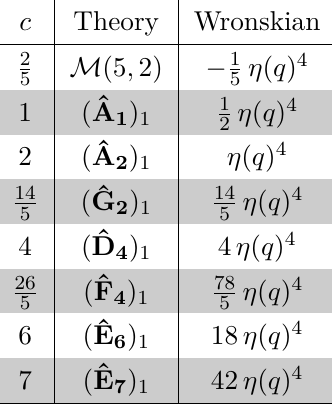
Table 2 . Wronskians.